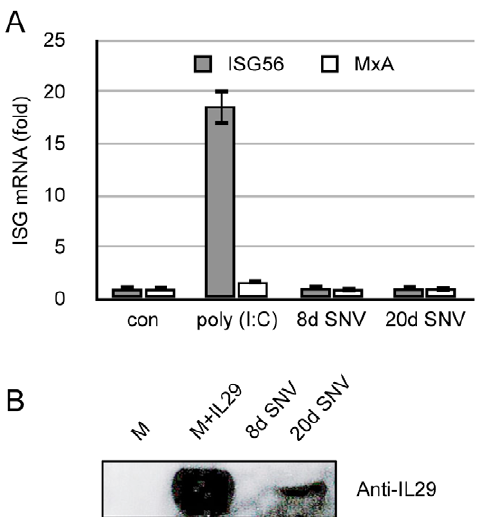
Figure 2. Vero E6-derived SNV stocks induce innate responses via a Jak/STAT pathway and contain IFN l . (A) Hec 1b Jak/STAT knockout cells were treated with poly (I:C) (50 m g/mL) or the indicated stock of virus from Figure 1 at an MOI=1 for 3 h. Total cellular RNA was isolated and used for qRT-PCR for ISG56 and MxA. Real-time qRT-PCR results are reported as the mean 6 SEM from triplicate biological experiments. (B) Medium supplemented with 50 m g/mL of rhIL29, and SNV derived from Vero E6 8 dpi and 20 dpi were applied to a 100-kDa filter and centrifuged for 10 min. The filtrate was then applied to a 3- kDa filter and centrifuged for 30 min. Equal volumes of the retentate were then used for SDS-PAGE. Western blotting was then performed using an anti-IL29 antibody.